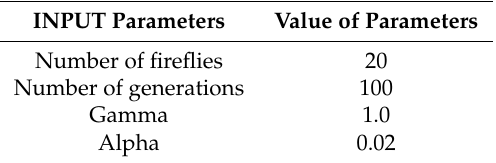
Table 5. Initial parameters of the firefly